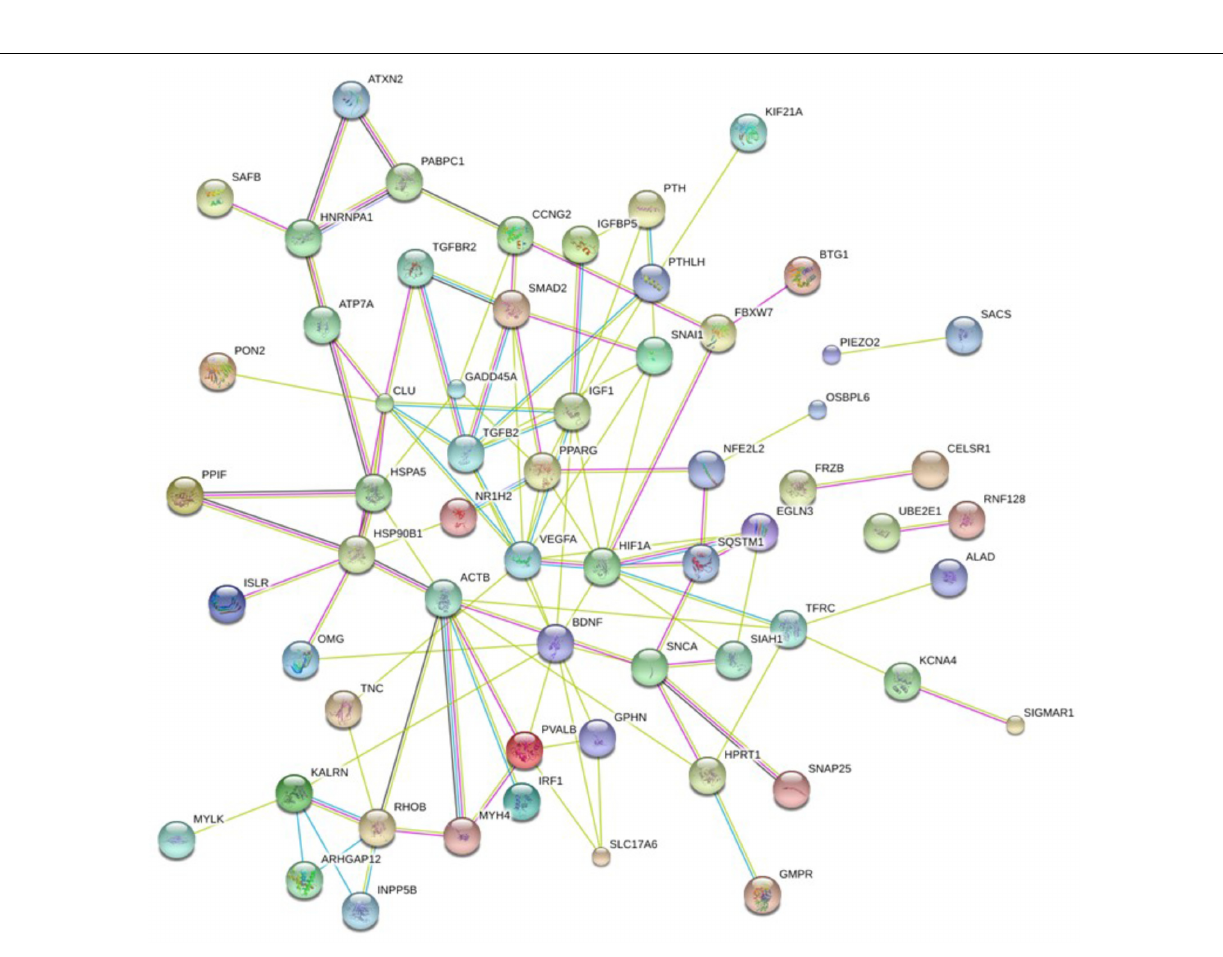
FIGURE 6 | Network showing protein–protein interaction (PPI) among identified target